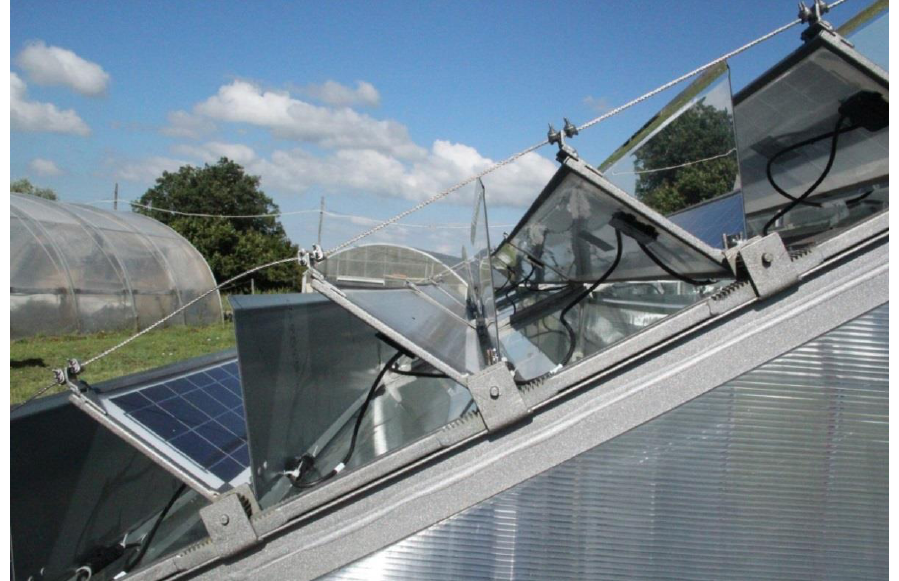
Figure 7. Detail of the movement system of the PV panels and mirrors.